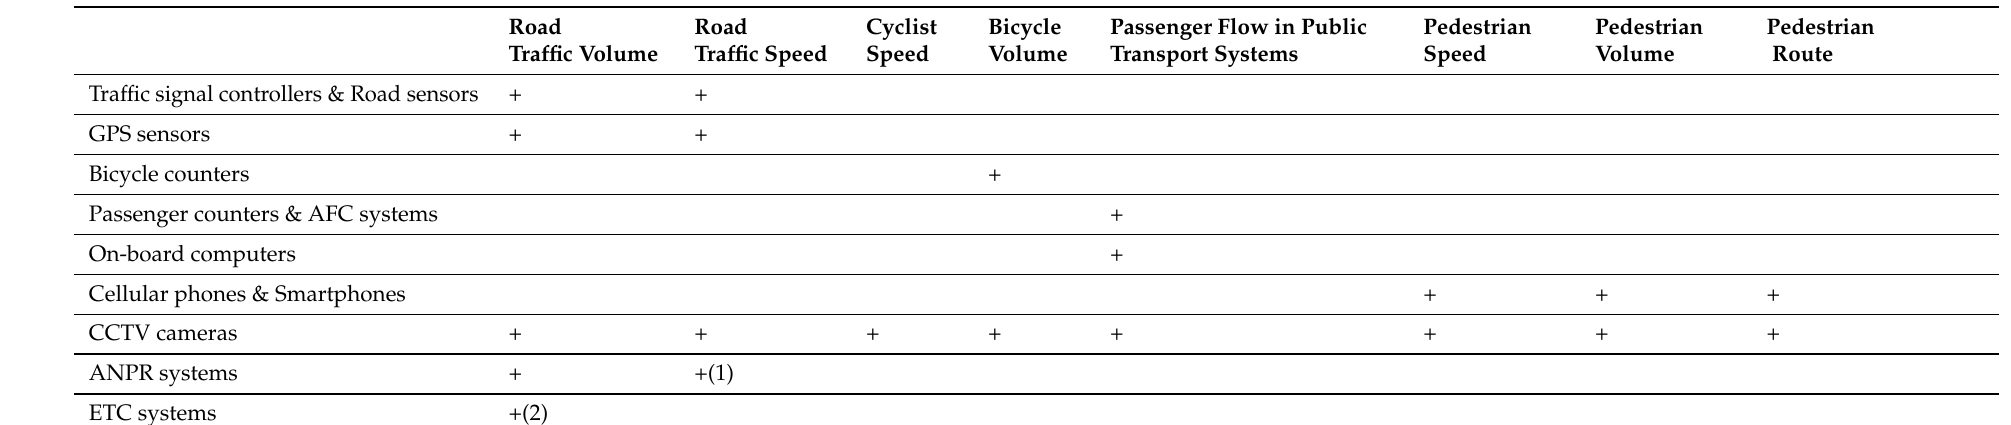
Table 9. A summary for the linking between data sources and possible